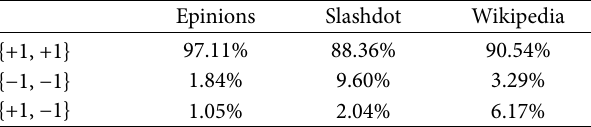
Table 8: Statistics of bi-directed